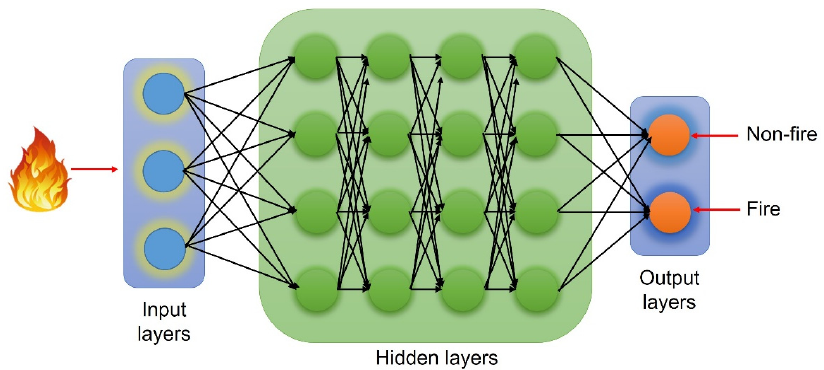
Figure 9. Schematic illustration of convolutional neural networks (CNNs) for fire detection.